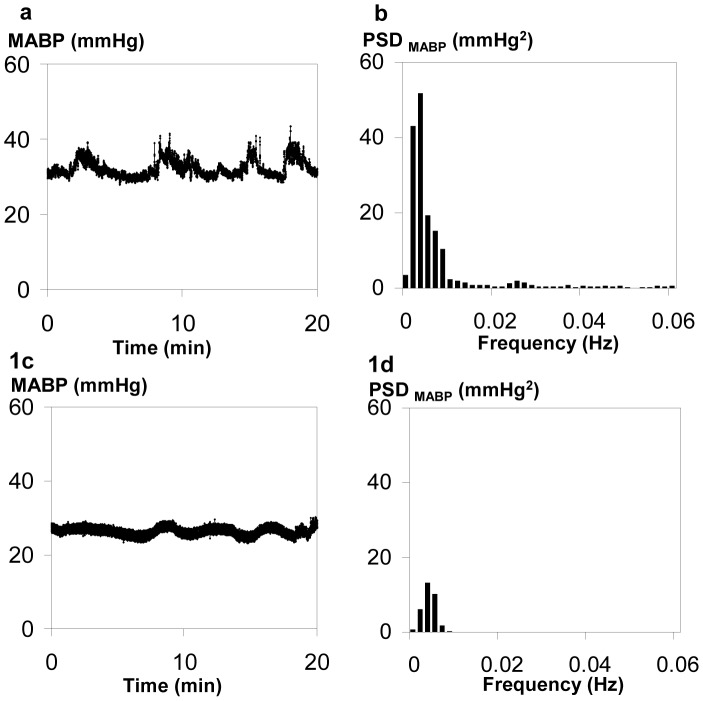
MABP waveform and its Power Spectral density (PSD).(a) Highly fluctuant MABP waveform over 20 minutes; (b) Power Spectral density (PSD) of MABP from (a) with averaged PSD of 9.6 mmHg2 in the frequency range of 0.003–0.02 Hz, signifying high BPV; (c) Minimally fluctuant MABP waveform; (d) PSD of MABP from (c) averaged between 0.003–0.02 Hz is 2.3 mmHg2, indicating low BPV.